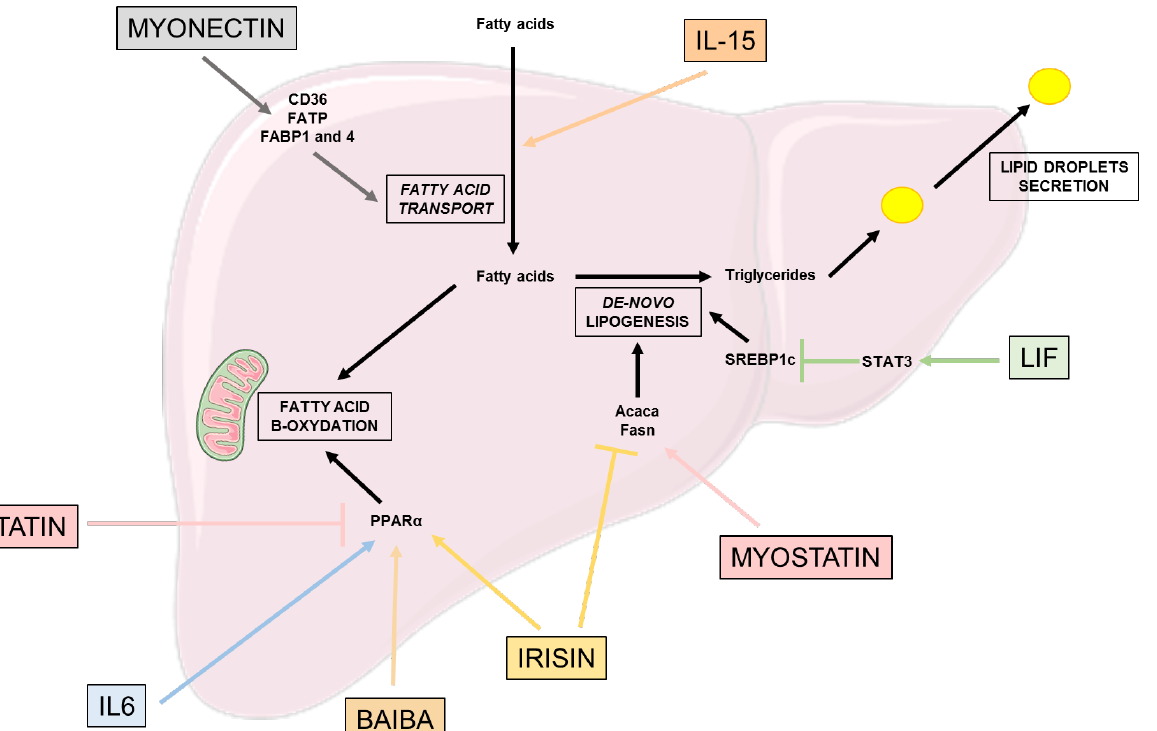
Figure 2. Effects of myokines on lipid metabolism. This figure highlights the beneficial and deleterious effects of different myokines on the different pathways involved in lipid metabolism: fatty acid transport, de-novo lipogenesis, fatty acid β-oxidation and lipid droplet secretion. Acaca: acétyl-CoA carboxylase 1; BAIBA: β-aminoisobutyric acid; CD36: Cluster of differentiation 36; FABP: Fatty acid binding protein; FATP: Fatty acid transport protein; Fasn: Fatty acid synthase; IL-6: Interleukine 6; IL-15: Interleukine 15; LIF: Leukemia inhibitory factor; PPARα: Peroxisome proliferator-activated receptor alpha; SREBP: sterol regulatory element binding protein; STAT3: Signal transducer and activator of transcription 3 .